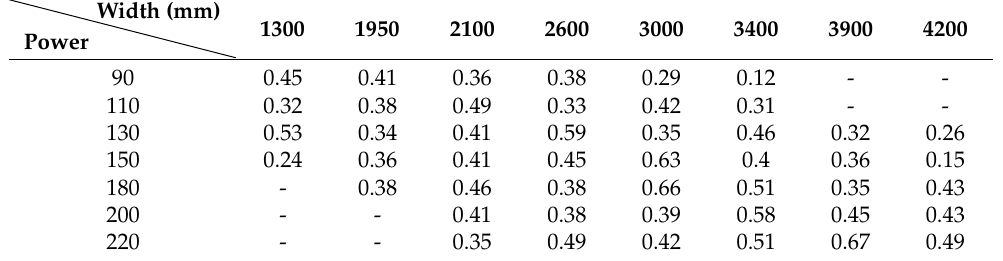
Table 6. Operation effect of different types of agricultural machinery and machines with different